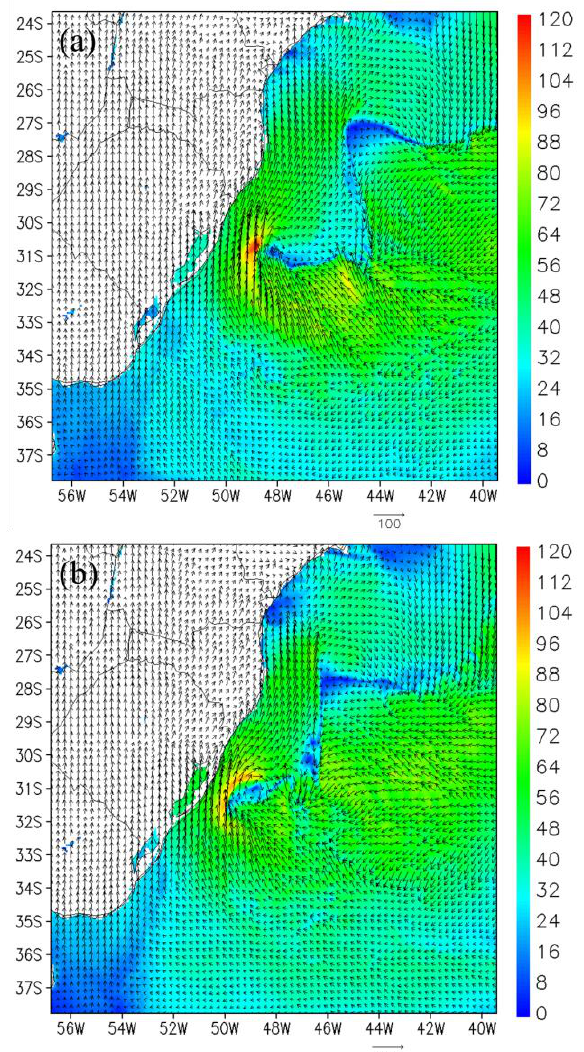
Figure 3. Wind speed (Km/h) and direction at 10 meters at 17 UTC on October 27, 2018. WRF simulations using NCEP FNL (a) and NCEP CFSv2 (b) as initial conditions. To quantify and evaluate the simulations, the wind speed values resulting from the WRF were compared with in situ observational data from INMET meteorological stations. This comparison is presented in Figure 4, with hourly wind speed values (m/s) between October 24 and 28, 2018. The quantification of this comparison was made by calculating the statistical metrics correlation coefficient (R), bias and Root Mean Square Error (RMSE). The results of the statistical analysis are presented in Table